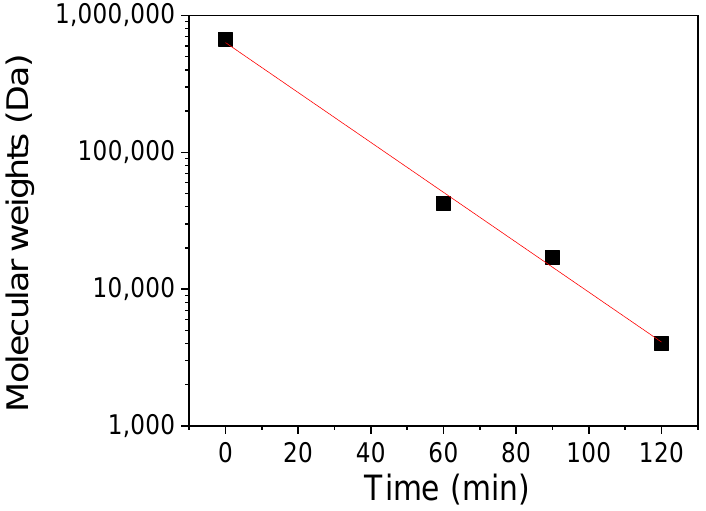
Figure 1. Influence of hydrolysis time on the molecular weight of oligocarrageenan.